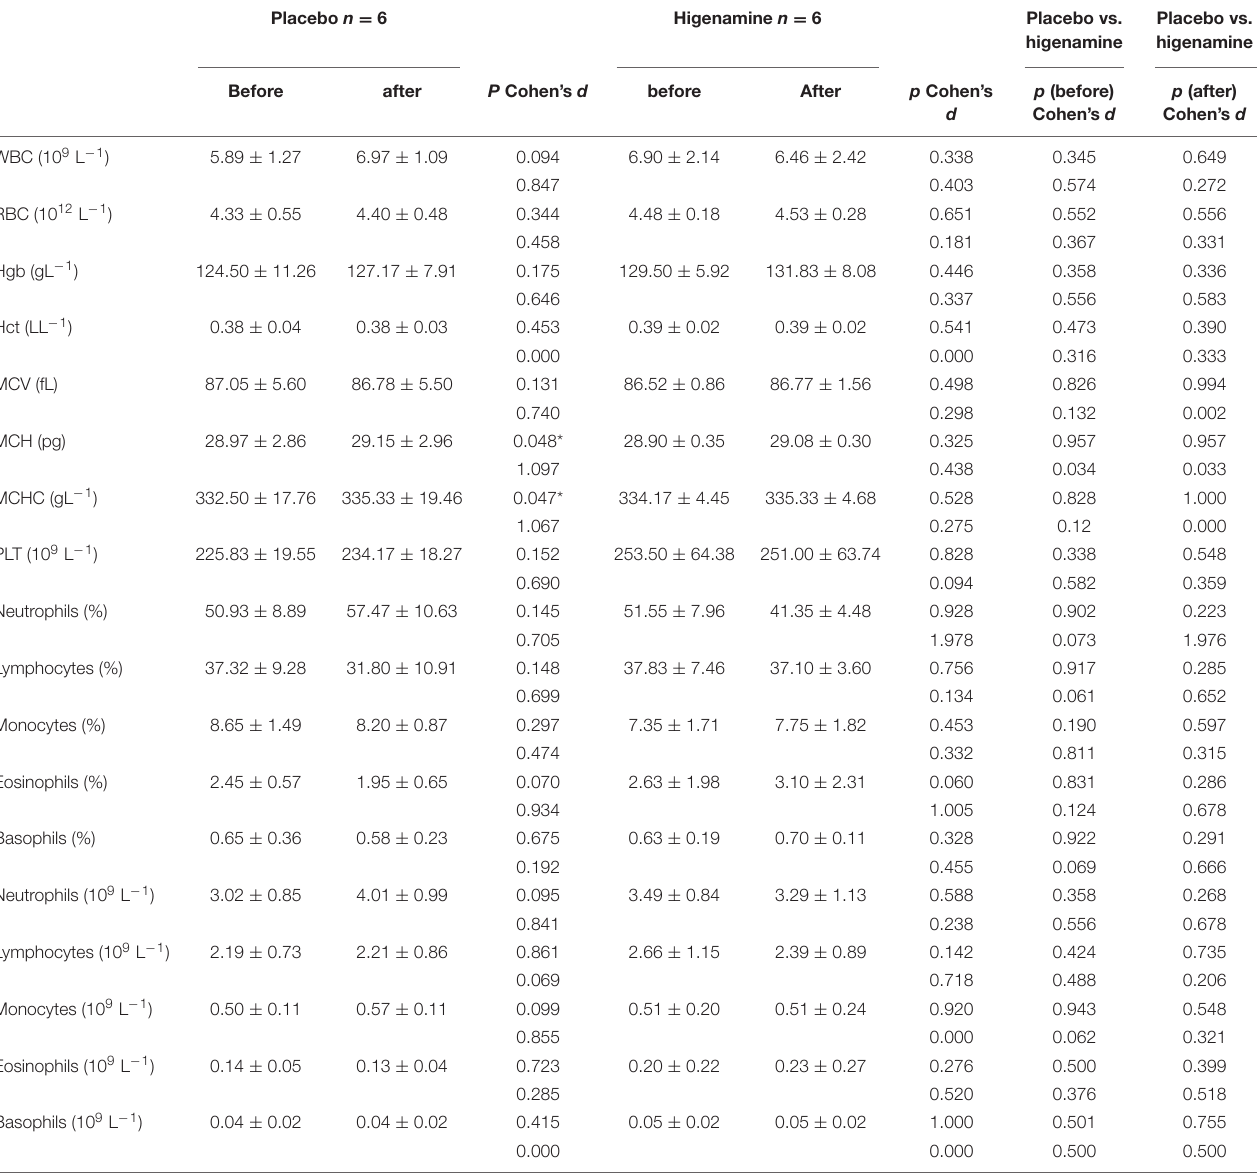
TABLE 2 | Blood parameters in placebo and higenamine groups before and after the treatment. Placebo n = 6 Higenamine n = 6 Placebo vs.